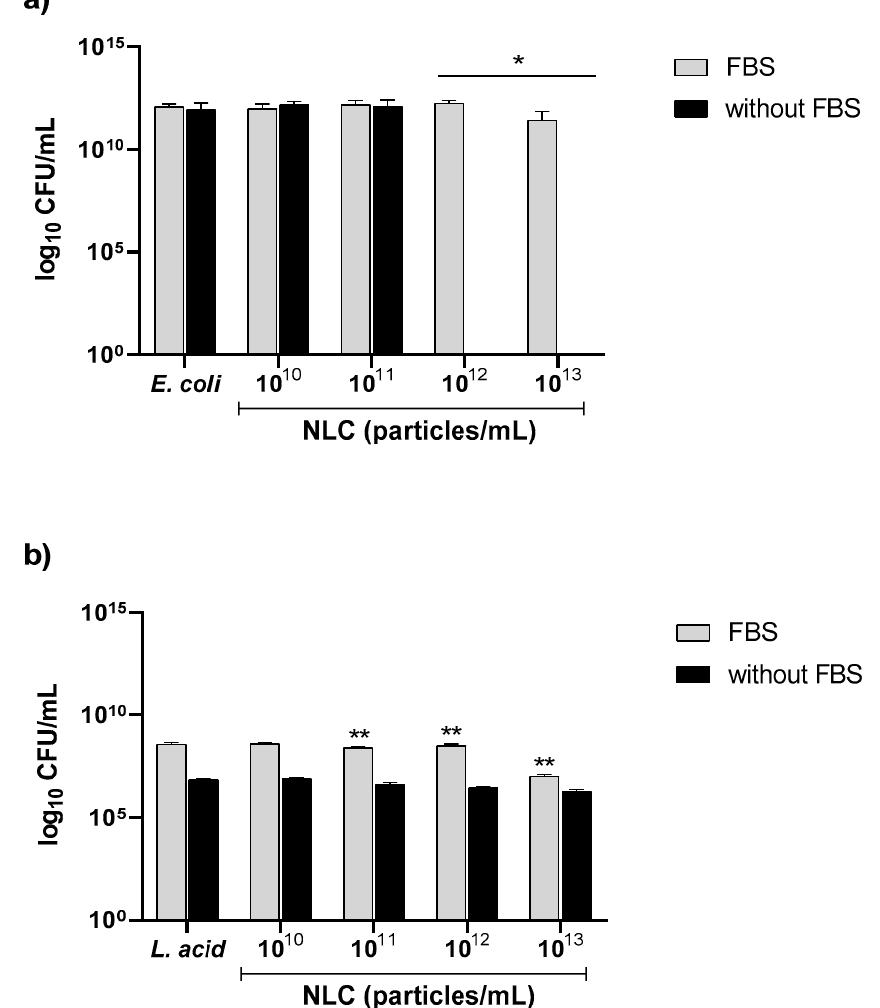
Figure 8. Antibacterial performance of NLC60 M against ( a ) E. coli and ( b ) L. acidophilus -01 grown in MHB with and without 10% FBS after 24 h of incubation. Data are expressed as means ± standard deviation. Statistical analysis was performed against the control medium using Tukey’s multiple comparisons test. * Samples with and without FBS ( p ˂ 0.05) and ** Samples in FBS ( p ˂ 0.05).